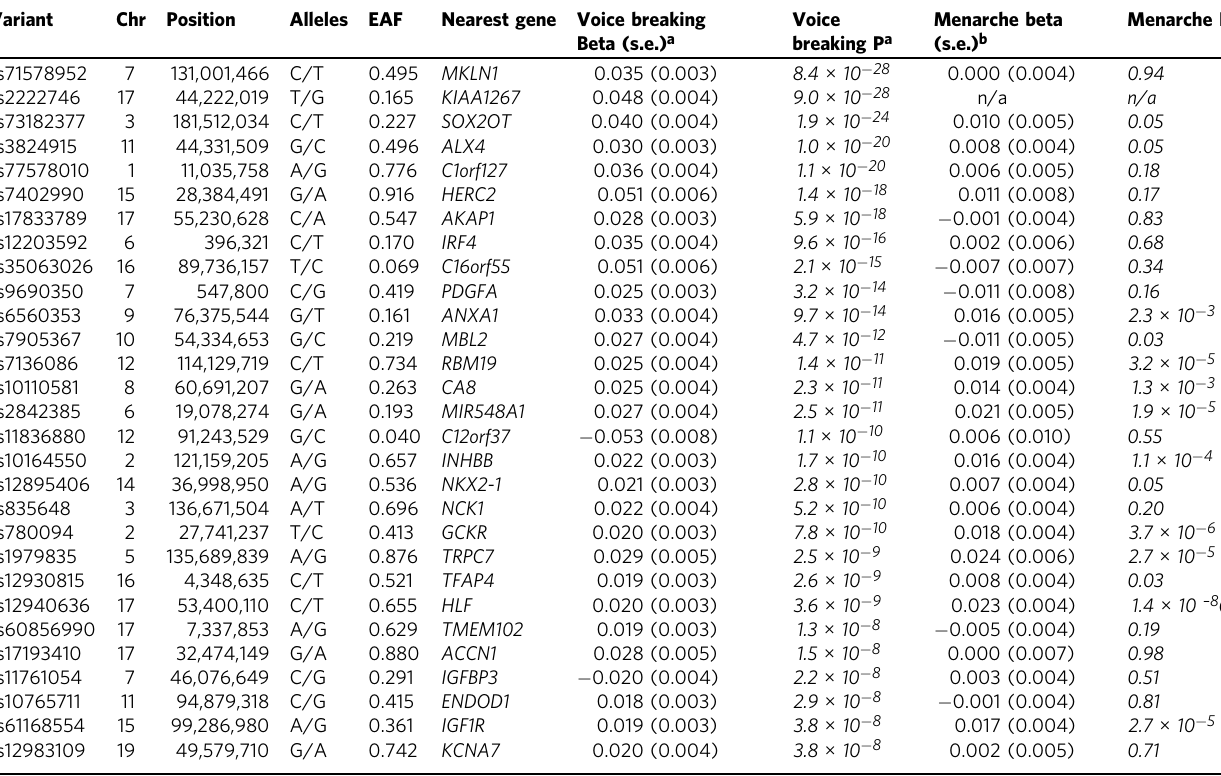
Table 1 Twenty nine previously unreported signals for puberty